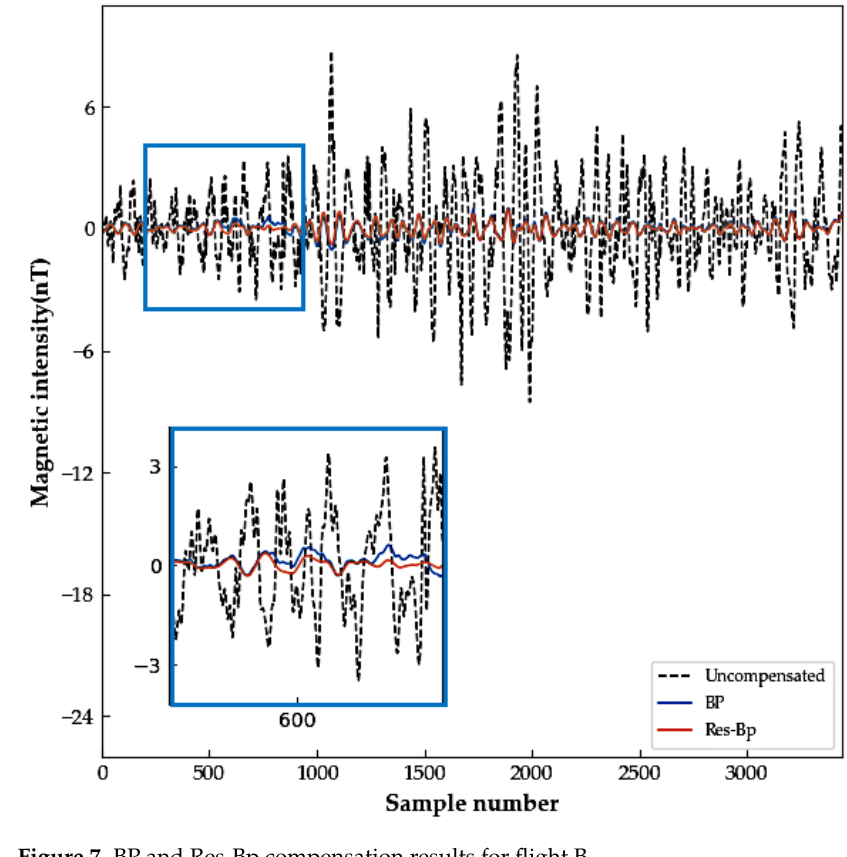
Figure 7. BP and Res-Bp compensation results for flight B.